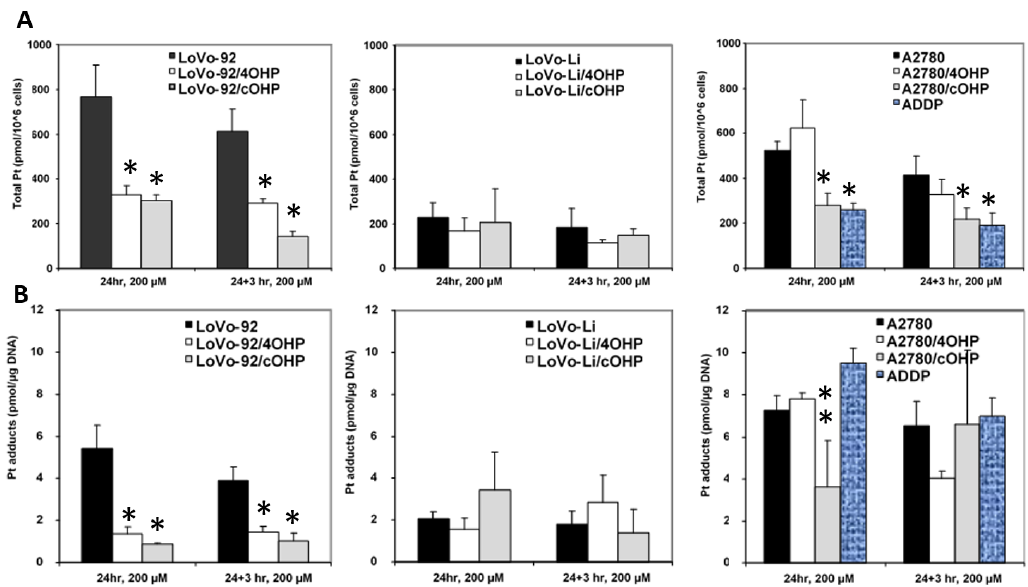
Figure 2. Total platinum accumulation ( A ) and platinum DNA adducts formation ( B ) in LoVo-92 variants, LoVo-Li variants, and A2780 variants. ADDP is a CDDP resistant variant of A2780. Values are means ± SEM of at least 3 experiments and expressed as pmol/10 6 cells ( A ) and as pmol/μg DNA ( B ). Cells were exposed for 24 h to 200 μM oxaliplatin and, in parallel, for 24 h followed by 3 h in a drug-free medium. Significant changes ( p < 0.05) compared to parental cell lines are marked with *, while ** was close to significance ( p = 0.055).